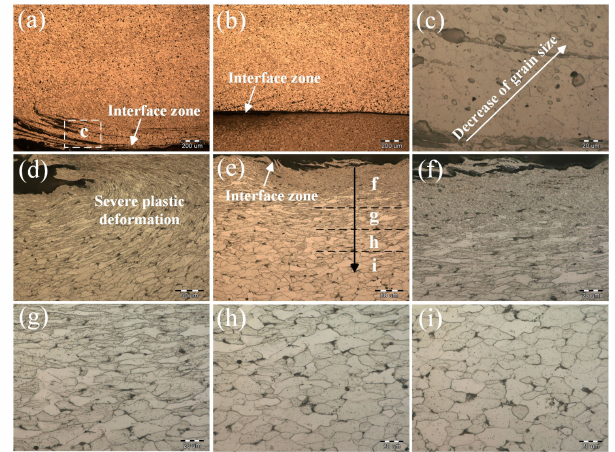
Figure 5. Interfacial microstructures of Al/steel lap joint with rotation speed of 1000 rpm and welding speed of 200 mm/min. ( a – c ) aluminum alloy side joint; ( d ) plastic deformed layer of steel side joint on retreating side; ( e ) plastic deformed layer of steel side joint in the center; and ( f – i ) higher magnifications shown in ( e